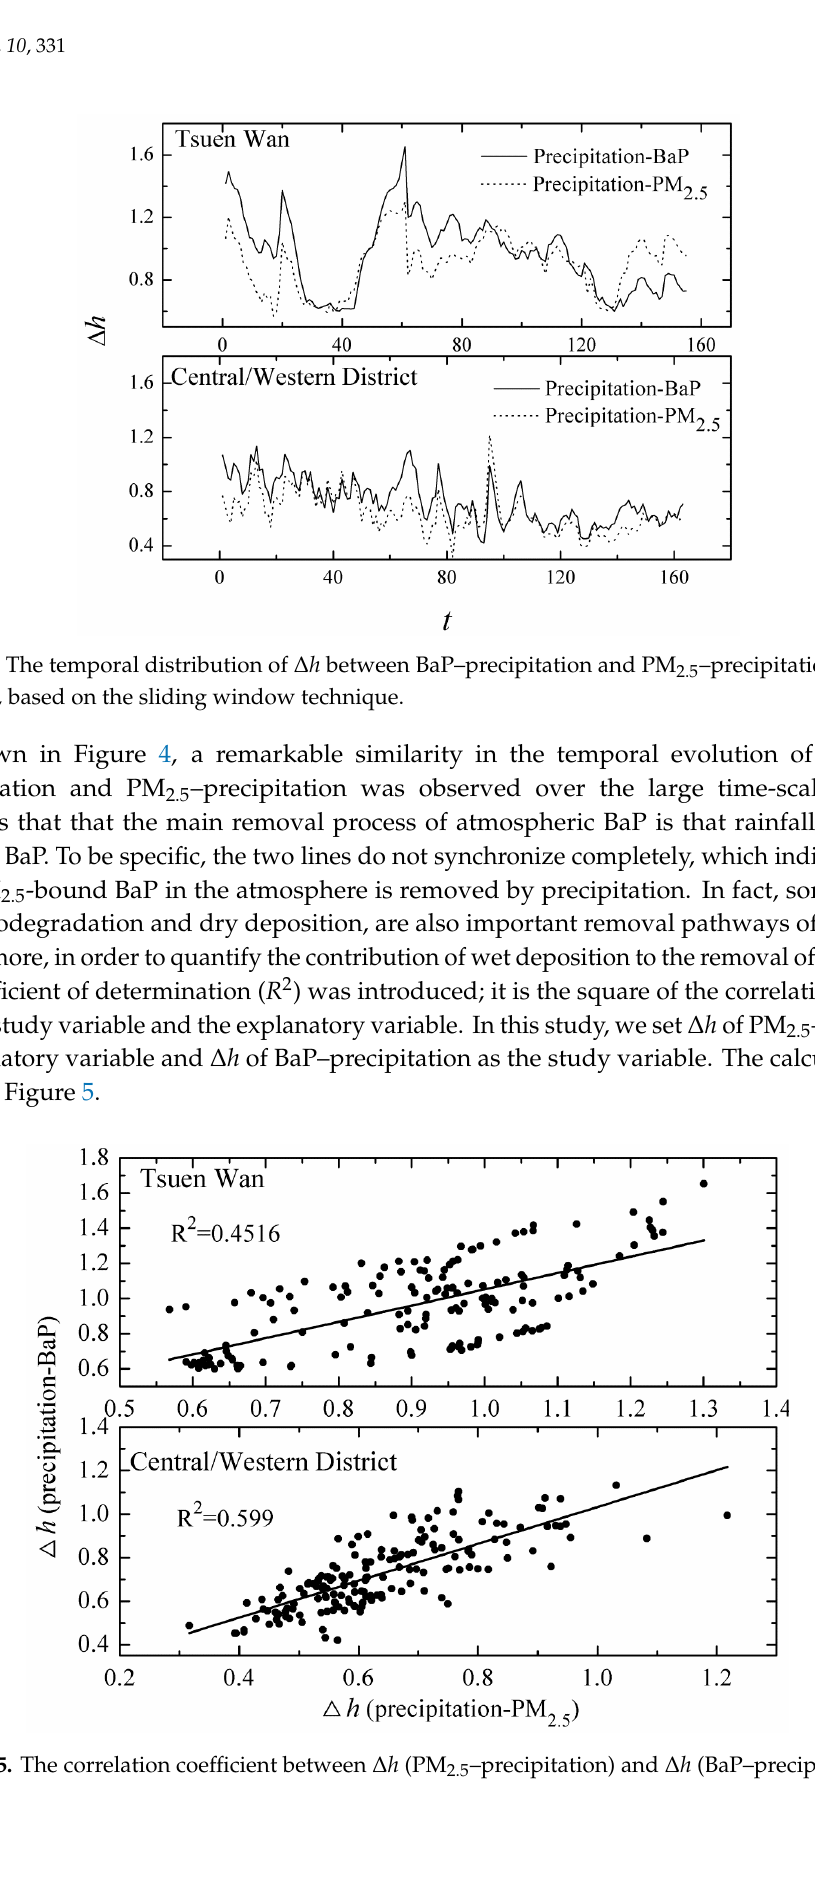
Figure 5. The correlation coefficient between Δ h (PM 2.5 –precipitation) and Δ h (BaP–precipitation).